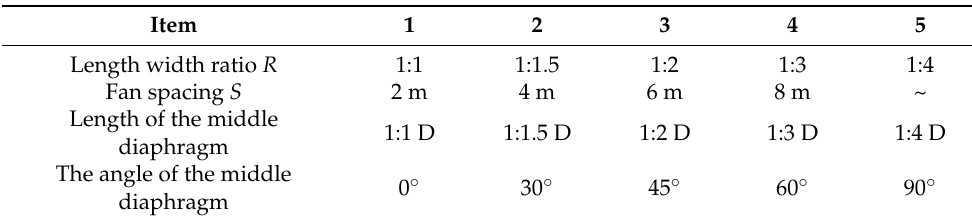
Item 4 ： Total resistance of ventilation system(Pa) Item 5 ： Total power of ventilation system(kW)